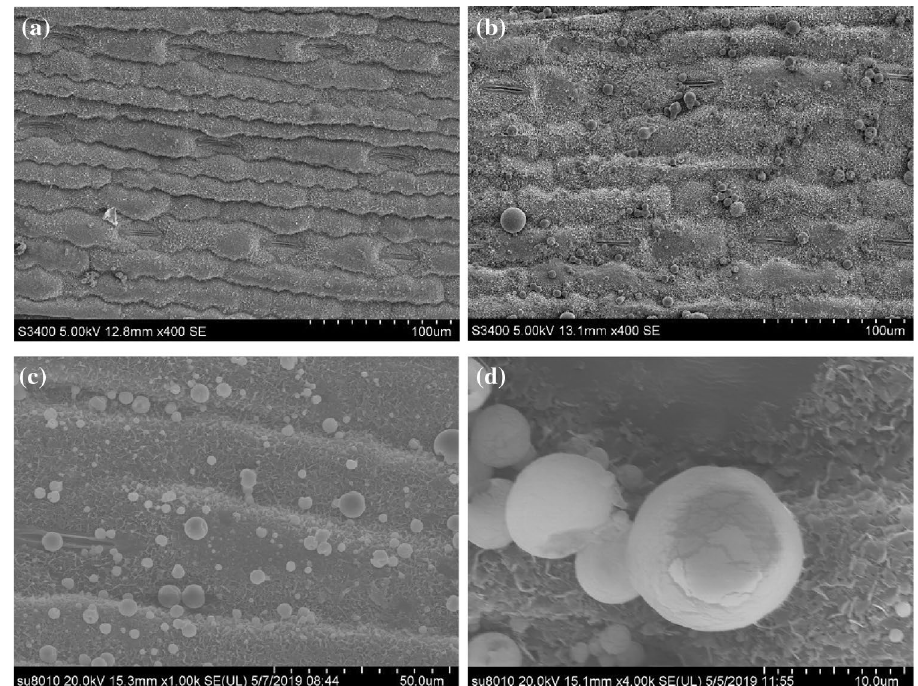
Figure 4. Stomata on a maize leaf. ( a ) shows stomata on the abaxial side; ( b ) shows stomata on the adaxial side; ( c ) magnified 1000 times of small spheres around the stomata of the adaxial leaf side; ( d ) magnified 1000 times of small spheres around the stomata of the adaxial leaf